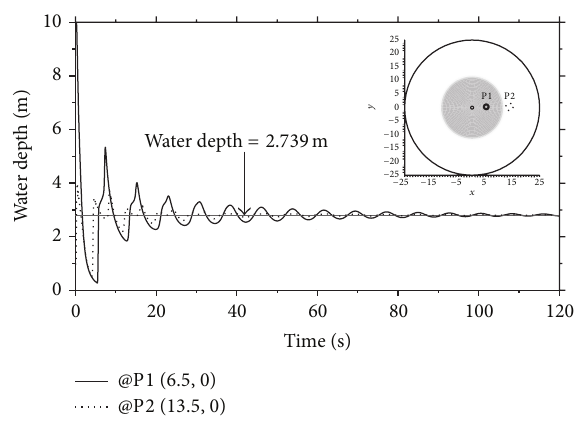
Figure 8: Depth convergence histories at two points after breaking of the circular